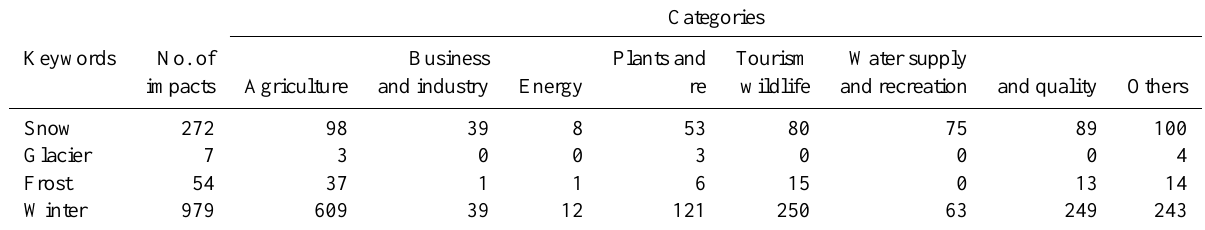
Table 6. Number of reported impacts for selected keywords and categories in the Drought Impact Reporter in the USA since